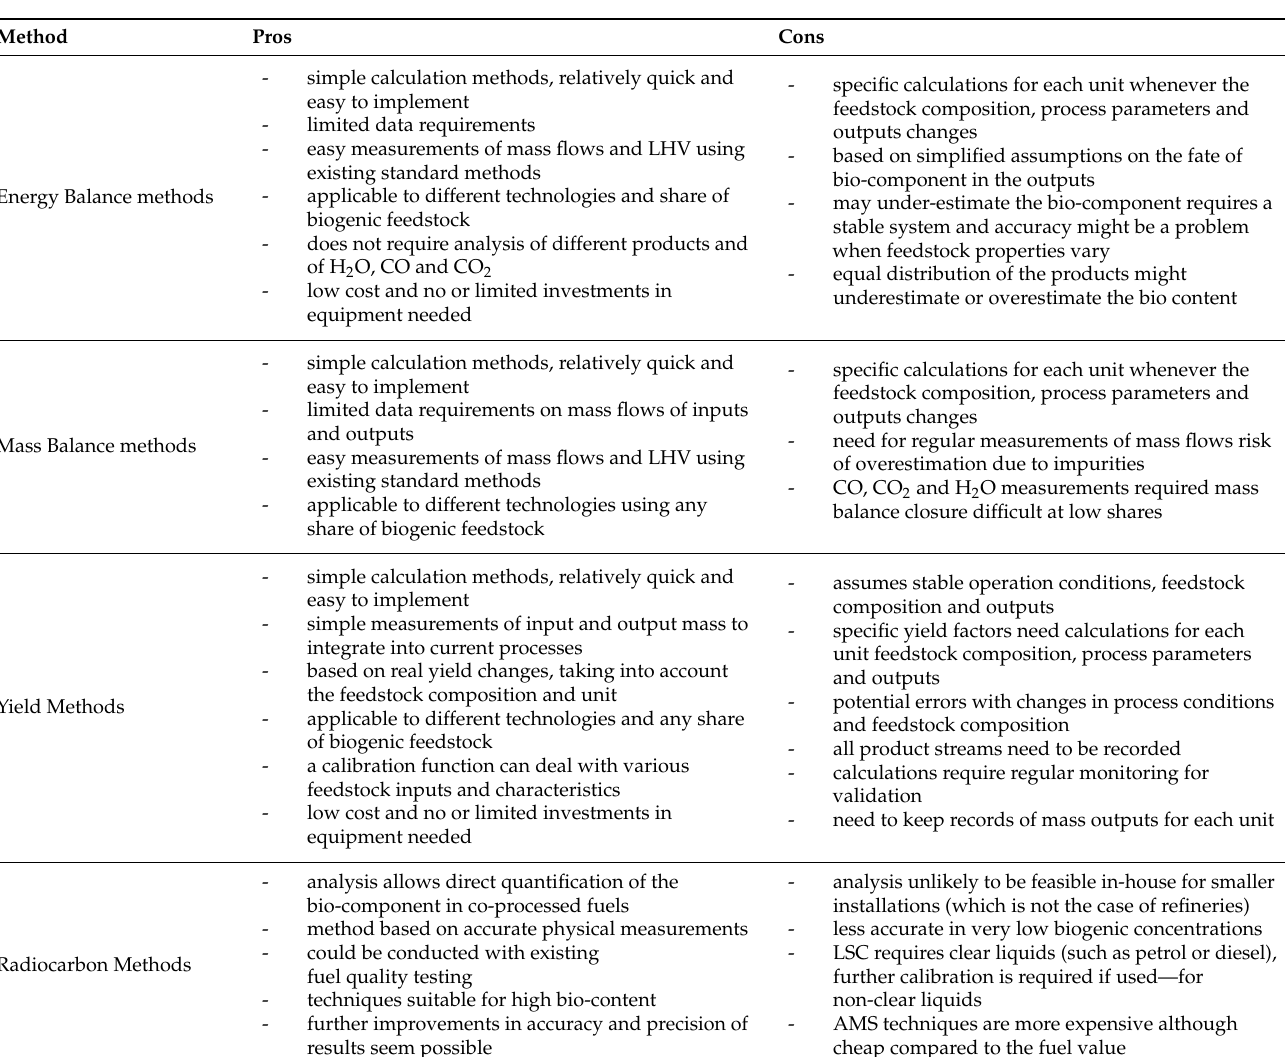
Table 3. Pros and cons for the methods to track the biogenic component of co-processing with fossil